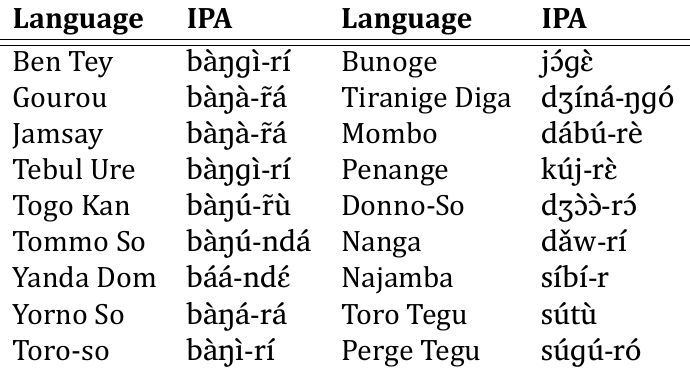
Table 1: Dogon terms for concept ‘hide, conceal something’